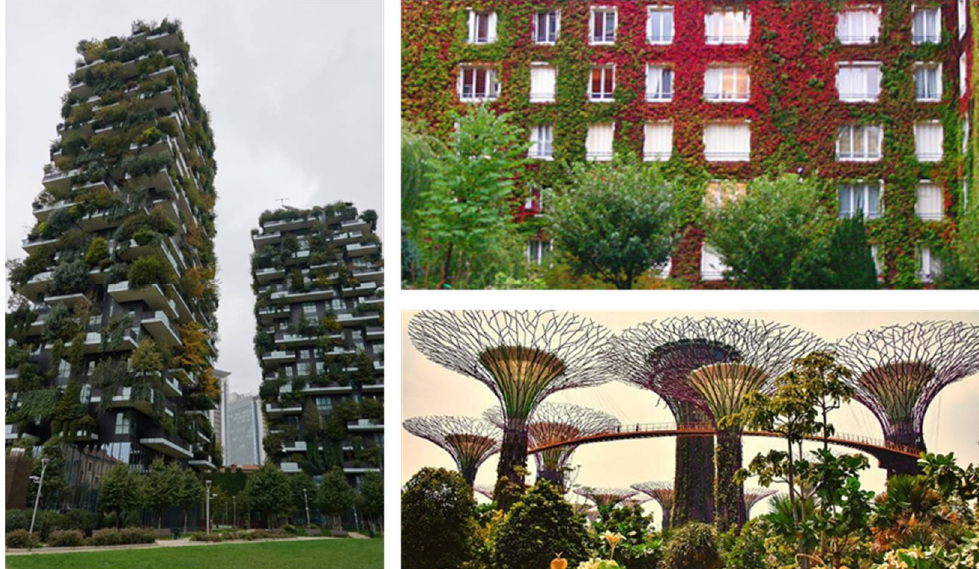
Figure 1. Common strategies to include vegetation on and around buildings. Image source: Bosco Verticale, CC BY-SA 2.0 ( left ), Green Wall, CC BY-SA 2.0 ( top right ), Gardens by the Bay, Singapore, and CC BY-SA 2.0 ( bottom right ).